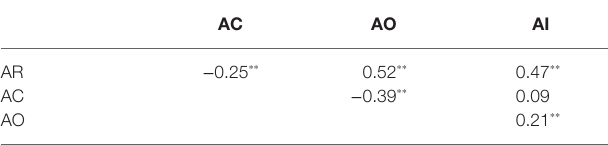
TABLE 1 | Socio-demographic characteristics of